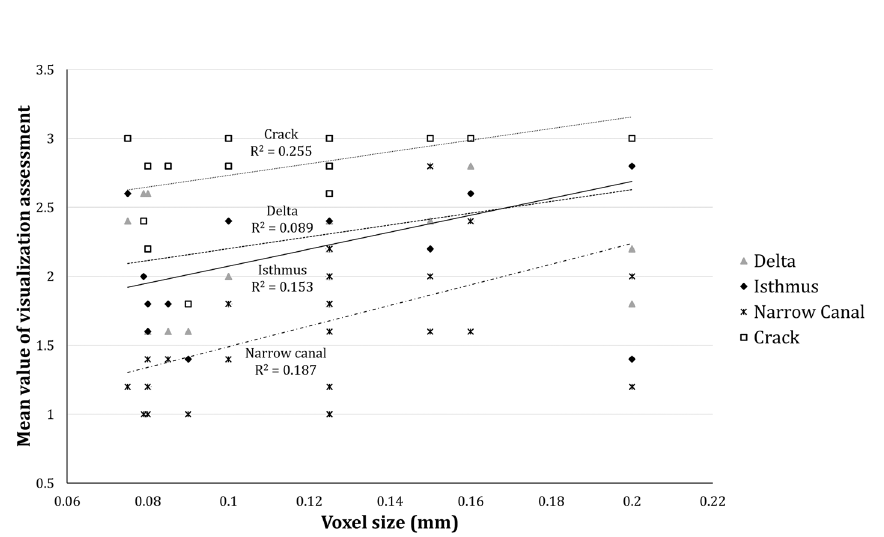
Figure 6. Relation between voxel size and mean assessment